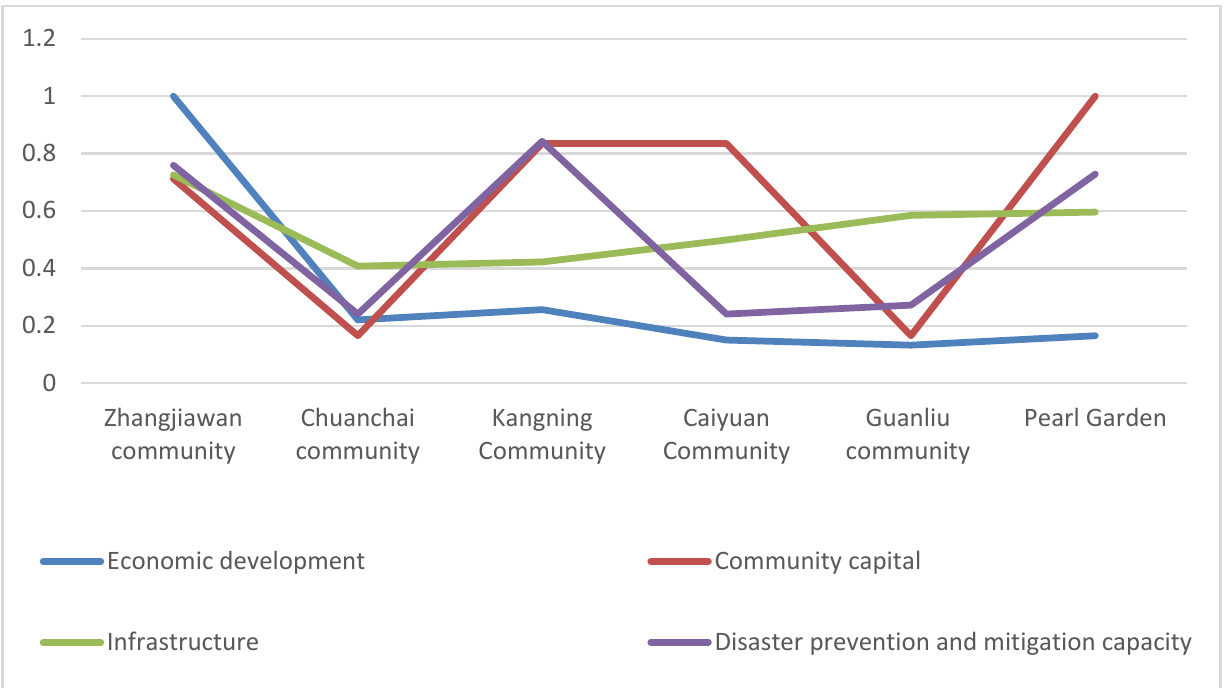
Figure 5. Comparison of six communities in the same dimension.